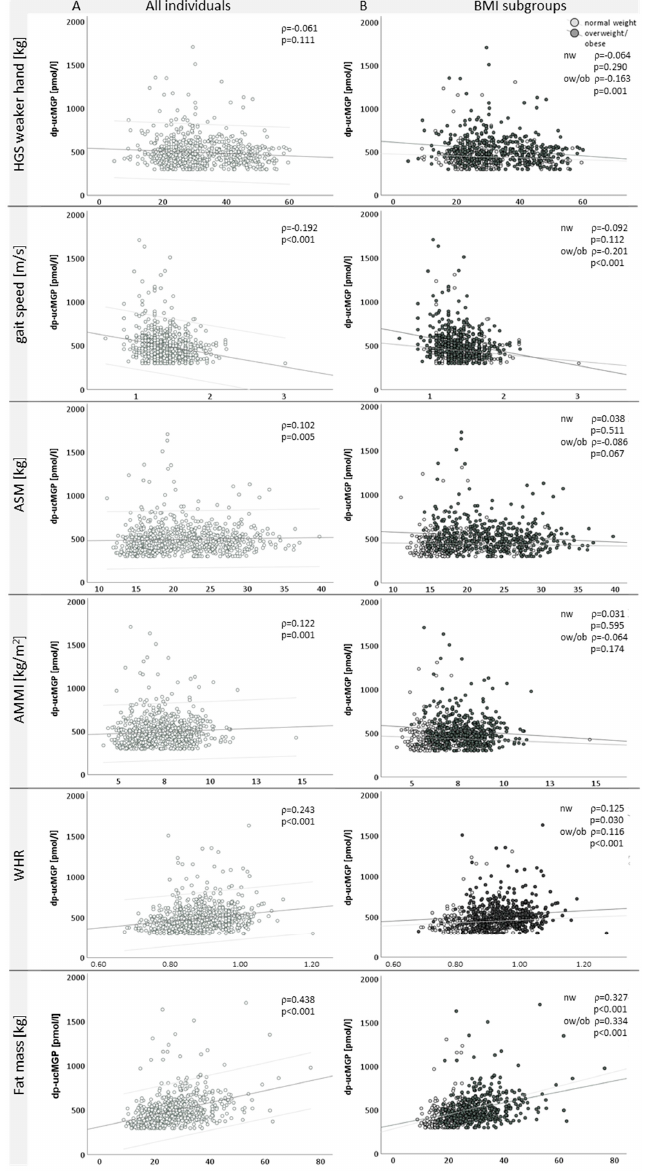
Figure 3. Circulating dp-ucMGP levels and correlations with sarcopenia-relevant parameters in all ( A ) and normal and overweight/obese ( B ) individuals. Correlation analysis between circulating dp- ucMGP and muscle parameters. Spearman’s rho ( ρ ) and p values are indicated. In all individuals, the 95% confidence interval is indicated by light grey lines. HGS: handgrip strength; ASM: appendicular skeletal muscle mass; AMMI: appendicular skeletal muscle mass index; WHR: waist-to-hip ratio; BMI: body mass index; kg: kilogram; min: minutes, L: liter; nw: normal weight; ow: overweight; ob: